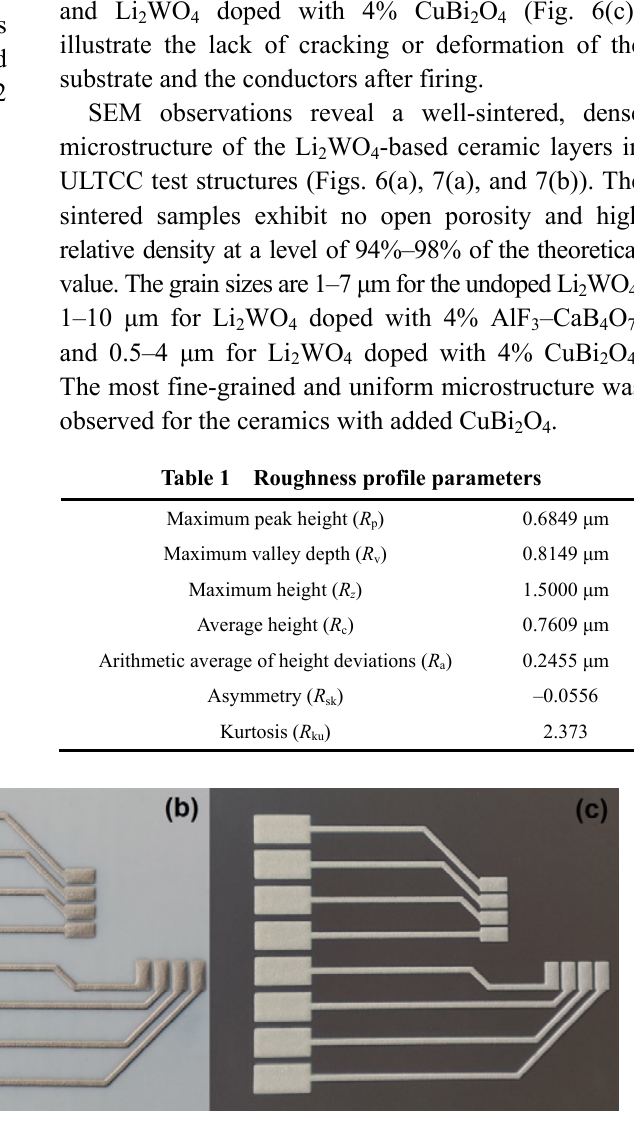
Fig. 5 (a) Rolled green tape based on Li 2 WO 4 , and green sheets with a screen printed test Ag conductor pattern: (b) Li 2 WO 4 doped with 4% AlF 3 –CaB 4 O 7 and (c) Li 2 WO 4 doped with 4% CuBi 2 O 4